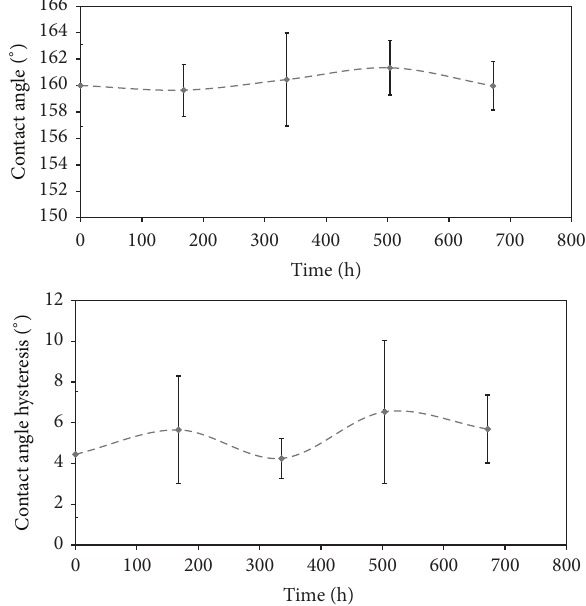
Figure 6: Thermal stability of the prepared superhydrophobic surface versus time.